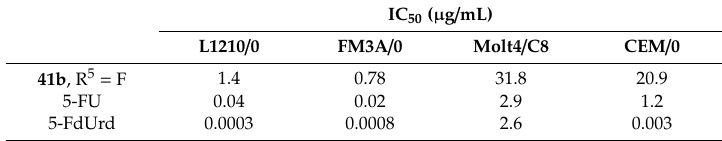
Table 15. The antiproliferative e ff ect of the pyrimidine 4,5-didehydro-5,6-dideoxy- l -ASA derivative.